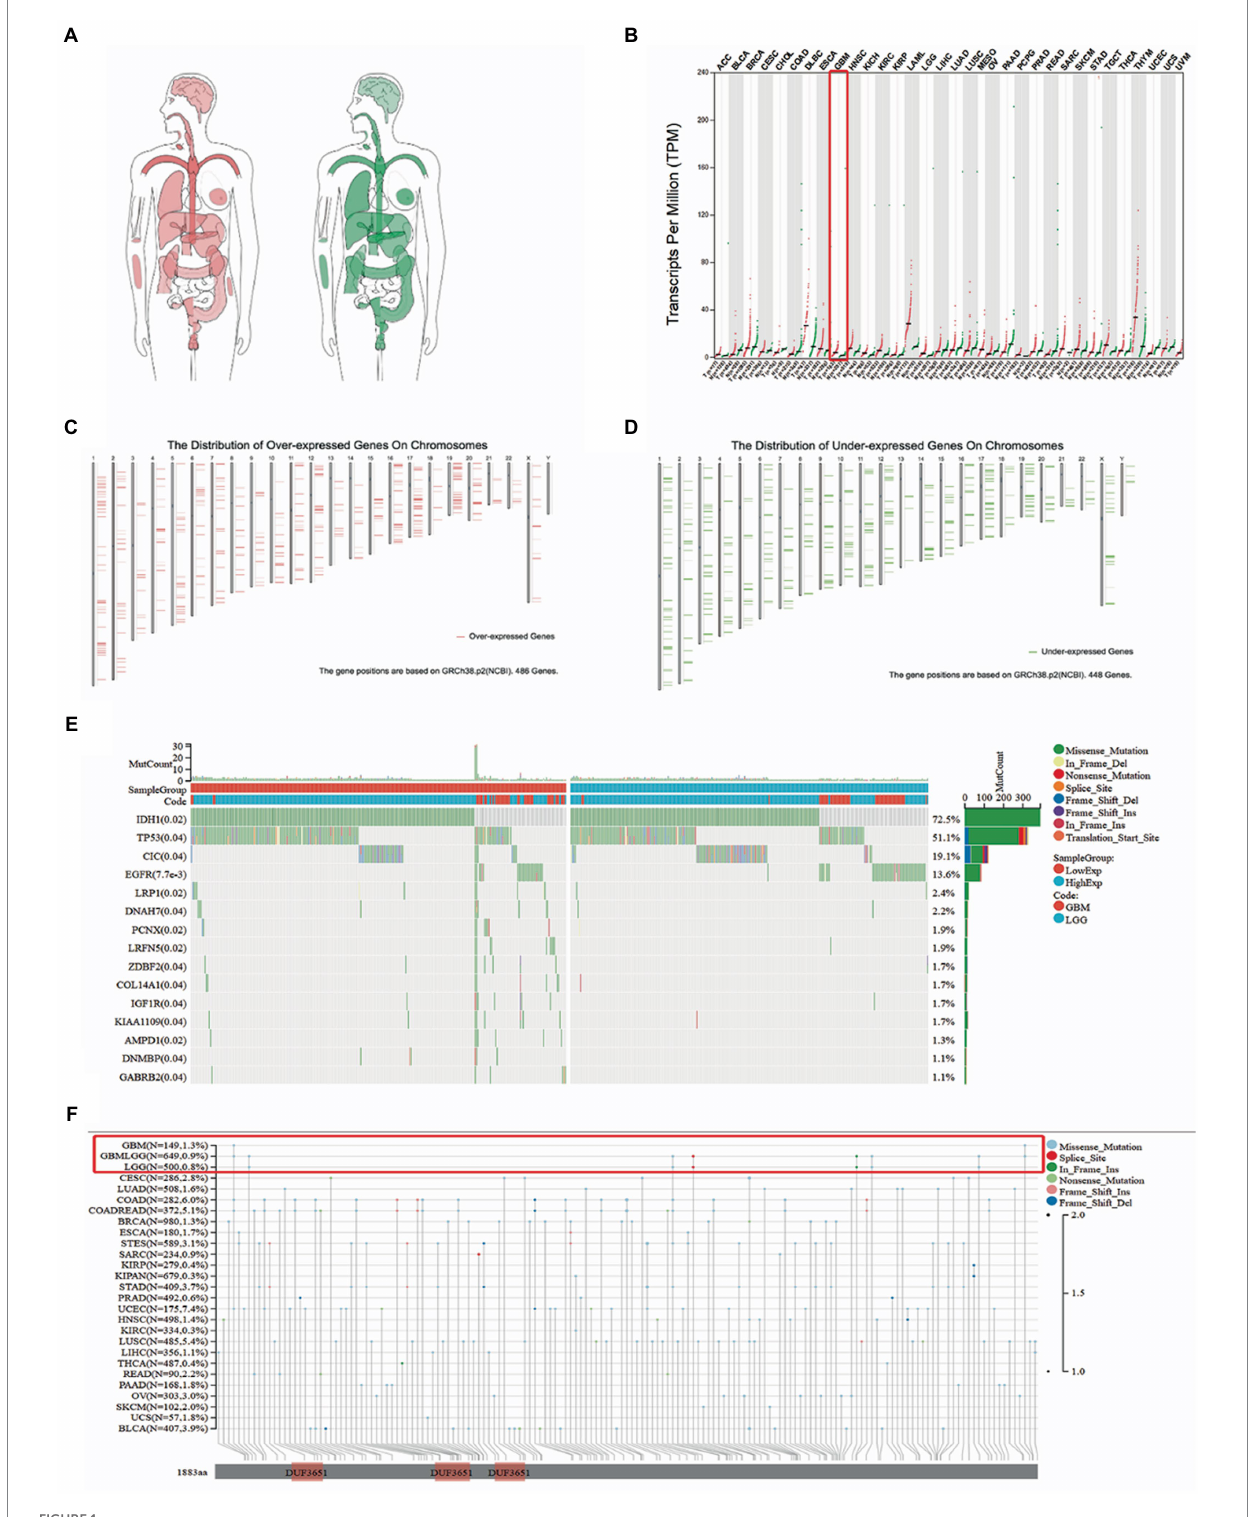
FIGURE 1 The expression of TMEM131L was analyzed by GEPIA database. (A) The expression of TMEM131L varies between tumor tissues (red) and normal tissues (green); (B) Differential expression map between tumor tissue and normal samples in pan-carcinoma; (C,D) Comparison of the position of mutations in each chromosome in glioma; (E) Top15 TMEM131L high and low expression related in TCGA-LGG data set, and gene mutation waterfall with significant difference in mutation frequency; (F) Pan-carcinoma analysis of TMEM131L mutation